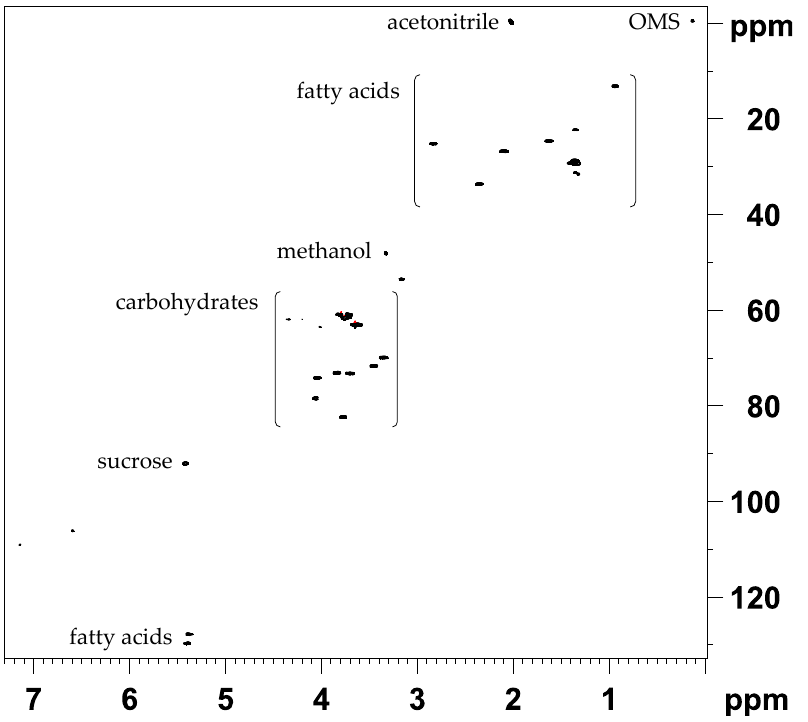
Figure 6. Representative 2D ASAP-HSQC spectrum (400 MHz) of a walnut sample extracted with acetonitrile- d 3 /methanol- d 4 (method B) showing mainly signals of fatty acids and carbohydrates. Due to the additional 13 C dimension, several signals occur less overlapping than in 1D NMR spec- tra.